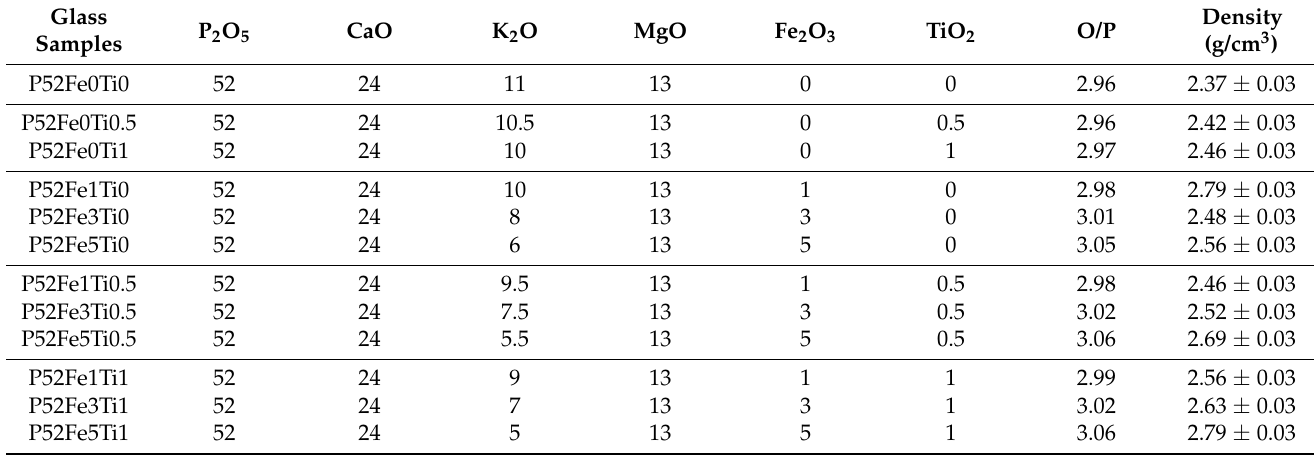
Table 1. Composition (%Mol) and density of phosphate glass